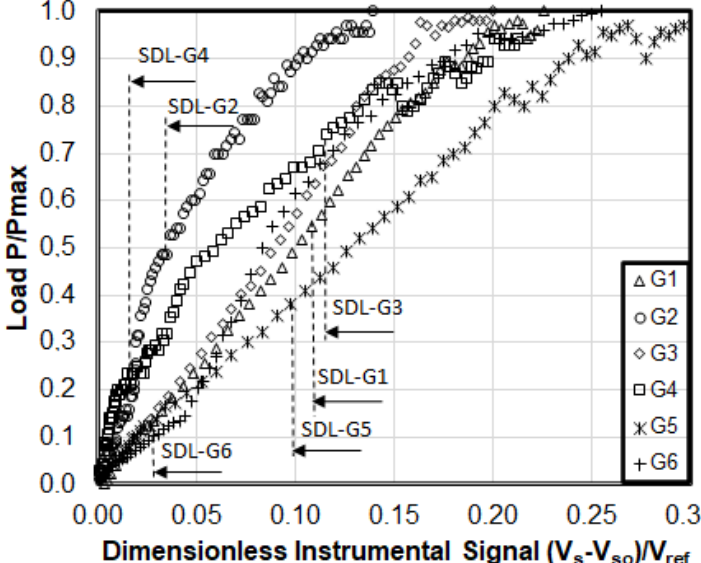
Figure 6. Dimensionless average load–instrumental signal curve from the bending tests using 1-s time-weighted average values.